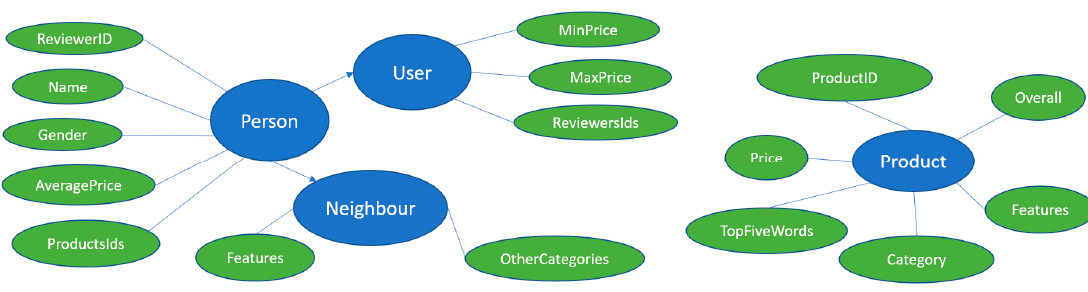
Figure 2. Ontology used, respectively classes and attributes.